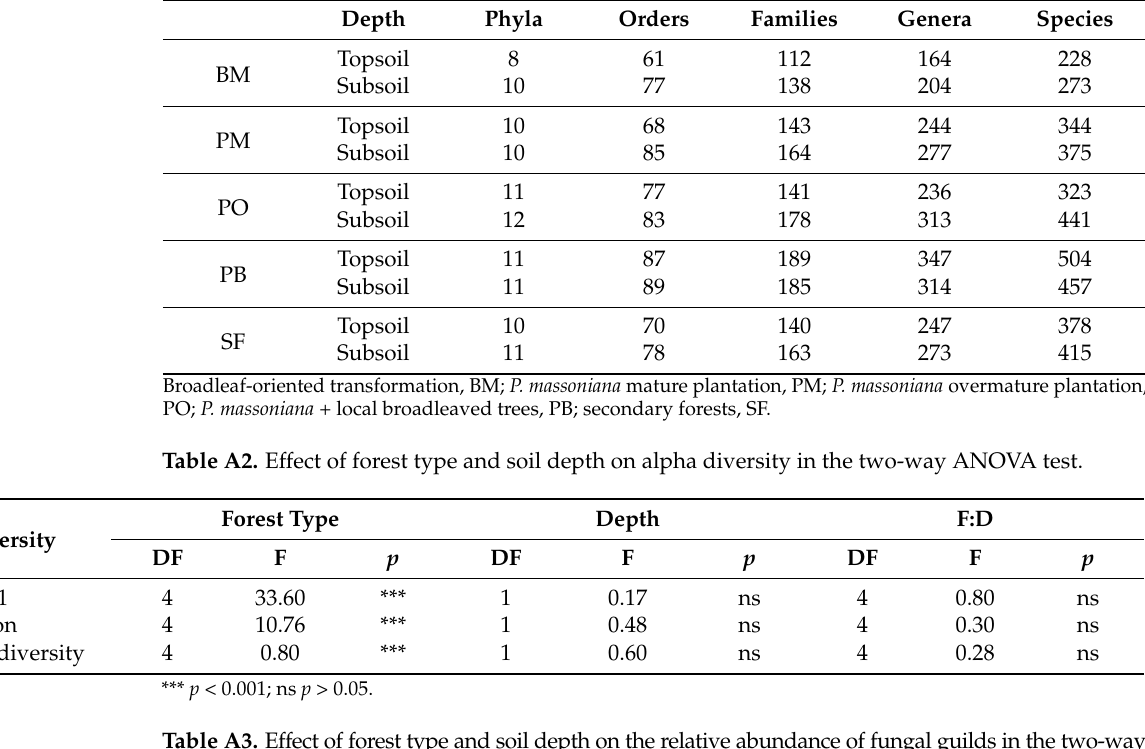
Table A3. Effect of forest type and soil depth on the relative abundance of fungal guilds in the two-way ANOVA